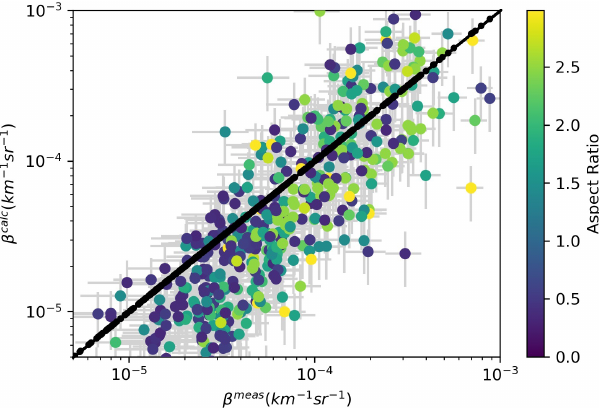
Figure 4. Scatterplot of computed vs. measured particle backscat- tering coefficients β A . The ARs used for the β computations have been selected, case by case, to produce the best agreement between the δ computed and measured values and are represented here by colour coding. Only ARs in the intervals between 0.3 and 0.55 lected within the interval 0.5–0.8µm to provide the best